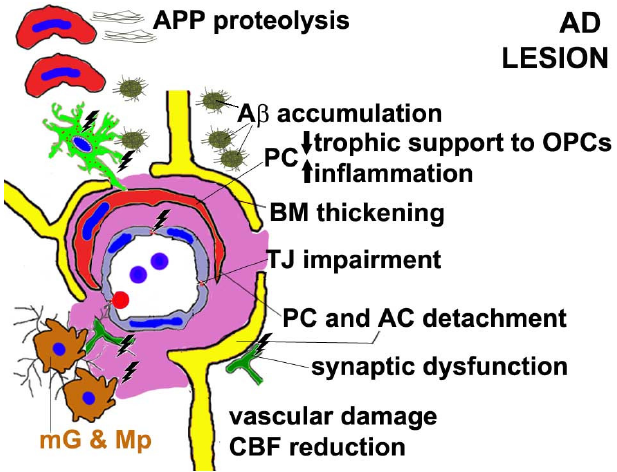
Figure 2. A schematic depiction of NVU components in Alzheimer’s disease (AD). The pericyte (PC) and astrocyte (AC) endfeet both appear detached from the vessel lumen, the perivascular basement membrane (BM) is thickened and vessel-associated microglial cells (mG) and macrophages (Mp) induce neuroinflammation. Dysfunctional PCs also release pro-inflammatory molecules and reduce the trophic support to oligodendrocyte precursor cells (OPCs)/NG2-glia. Altogether, these dysfunc- tions induce vascular damage and a reduced cerebral blood flow (CBF), acting via altered amyloid precursor protein (APP) proteolysis and consequent amyloid β accumulation inducing synaptic dysfunction and neuronal loss. 9. PC Dysfunction in Multiple Sclerosis (MS) As already stated, PCs and OPCs reciprocally interact to ensure myelin development and maintenance and BBB integrity at the NVU interface [69,145,149,150,153,154]. An al- tered interaction leads to demyelinating events and disturbs remyelination attempts of demyelinating plaques in MS and animal models of demyelination/remyelination [69,232]. MS is a progressive autoimmune disease of unknown aetiology that affects the CNS of young adults, in which immune cells react against myelin antigens. It is charac- terized by early BBB breakdown preceding multiple demyelinating lesions which com- monly include gliosis, axon degeneration, neuronal loss and remyelination attempts [234– 238]. The evidence supporting a role of microvascular brain PCs in MS derives from de- tailed analyses of post-mortem brain tissues from MS-affected patients at an early phase of their secondary progressive MS course in comparison with others at a late phase of their progressive course. Perivascular cell subpopulations (including PCs) behave differently depending on the lesion type and clinical course of the disease [239]. Active lesions con- tain higher numbers of proliferative perivascular cells than inactive lesions, while chronic lesions display lower numbers of proliferative perivascular cells than normal-appearing white matter (i.e., healthy tissue external to demyelinating plaques). Apart from neuropathology, another substantial contribution to the MS research field has been provided by animal models built in order to reveal cellular and molecular mech- anisms of demyelination/remyelination and to develop novel approaches to MS treat- ment. Experimental autoimmune encephalomyelitis (EAE) in rodents is the animal model most commonly used to study demyelination/remyelination, neurodegeneration and neu- roinflammation processes that closely resemble features of human MS [240]. Other exper- imental models specifically developed to study demyelination/remyelination processes are based on the administration of chemicals that promote systemic or focal CNS demye- lination [241]. In EAE, NG2 + OPCs make many more contacts with NG2 + PCs of cerebro- cortical microvessels, determining TJ impairment and BBB leakage (Figure 3, Table 2). The absence of NG2, in both OPCs and PCs, reduces the number of vessel-contacting OPCs and restores the BBB integrity [69,144,242,243].